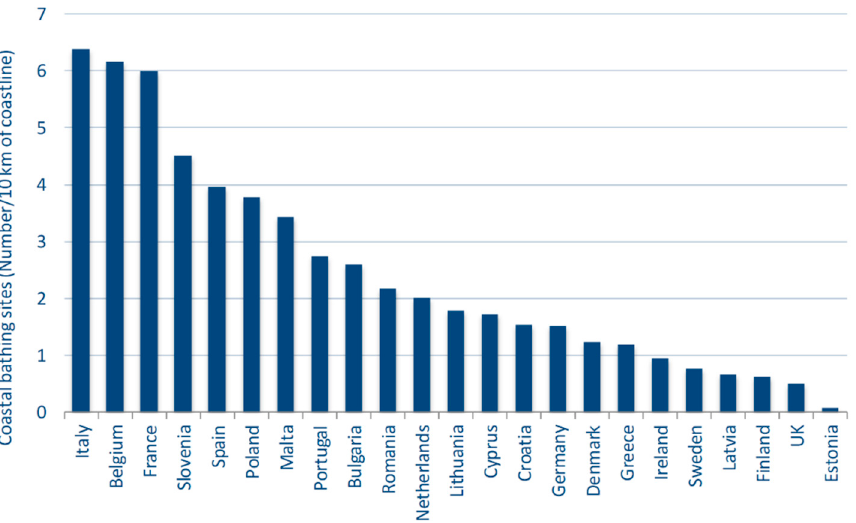
Figure 8. Number of coastal bathing sites in relation to the length of the coastline in EU Member